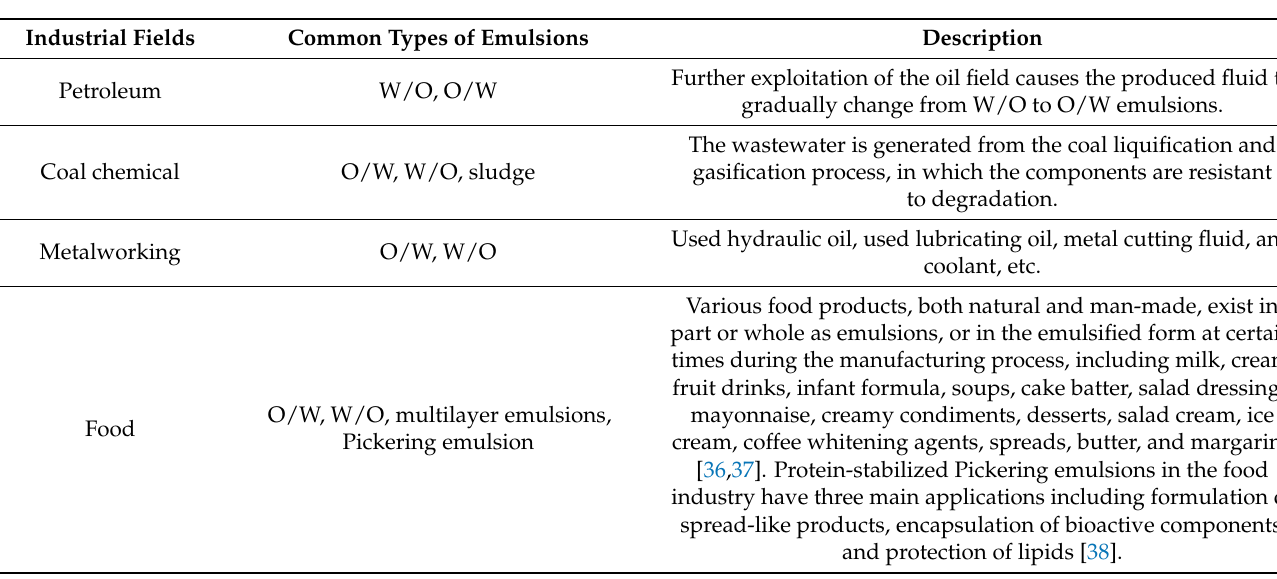
Table 5. Common types of emulsions in various